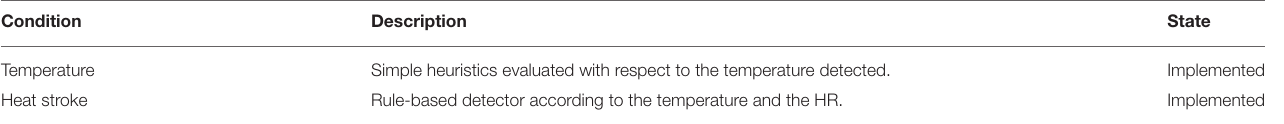
TABLE 4 | Approaches integrated in ATTICUS for the detection of temperature-related